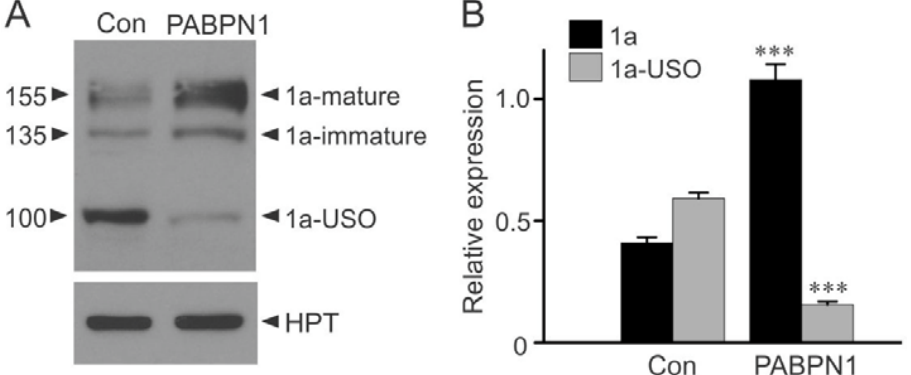
Figure 5. Regulation of Kv11.1 isoform protein expression by PABPN1. ( A ) Immunoblot analysis of Kv11.1 protein from Flp ‐ In HEK293 cells stably expressing the short KCNH2 gene following trans ‐ fection of vector control (Con) or PABPN1. The expression level of hygromycin B phosphotransfer ‐